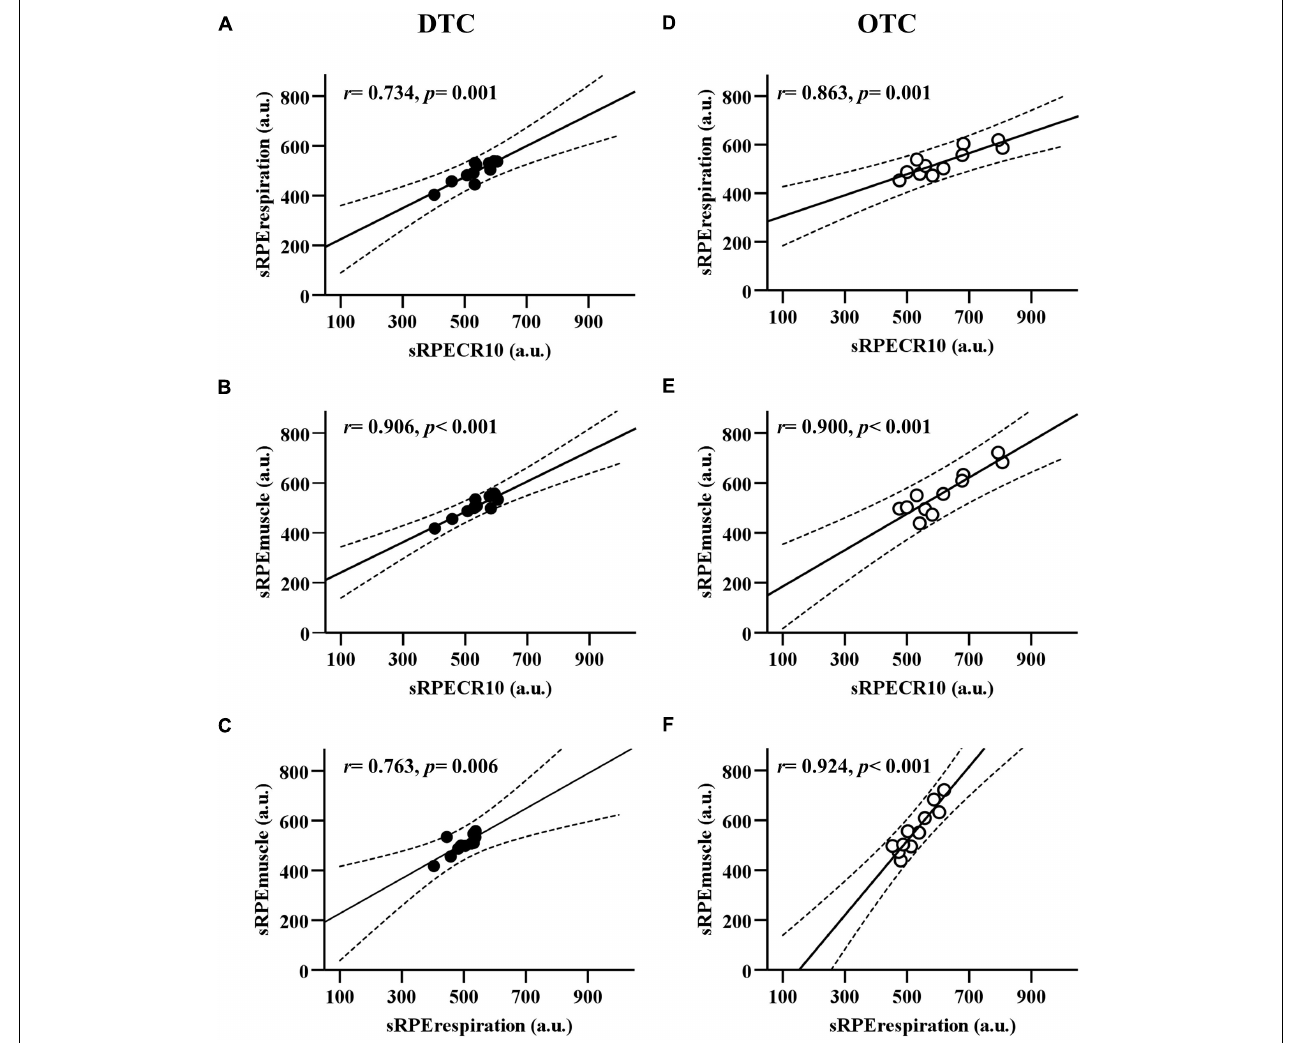
FIGURE 3 | The linear regression between sRPE CR10 , sRPE respiration , and sRPE muscle during domestic and overseas training camps. (A) Comparison between sRPE CR10 and sRPE respiration during DTC. (B) Comparison between sRPE CR10 and sRPE muscle during DTC. (C) Comparison between sRPE respiration and sRPE muscle during DTC. (D) Comparison between sRPE CR10 and sRPE respiration during OTC. (E) Comparison between sRPE CR10 and sRPE muscle during OTC. (F) Comparison between sRPE respiration and sRPE muscle during OTC. sRPE CR10 , session rating of perceived exertion CR10; sRPE respiration , session respiratory perceived exertion; sRPE muscle , session muscular perceived exertion; DTC, domestic training camps; OTC, overseas training